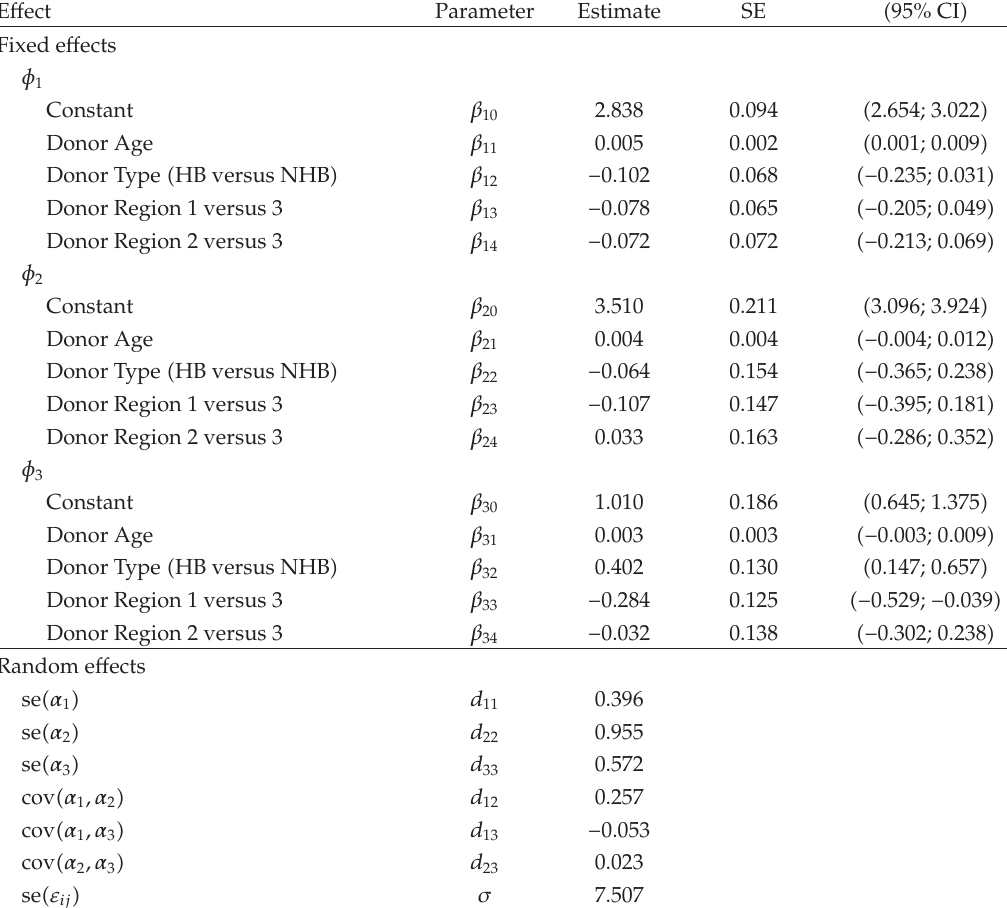
Table 1: Parameter estimates, standard errors, and 95% confidence intervals from the nonlinear mixed model for